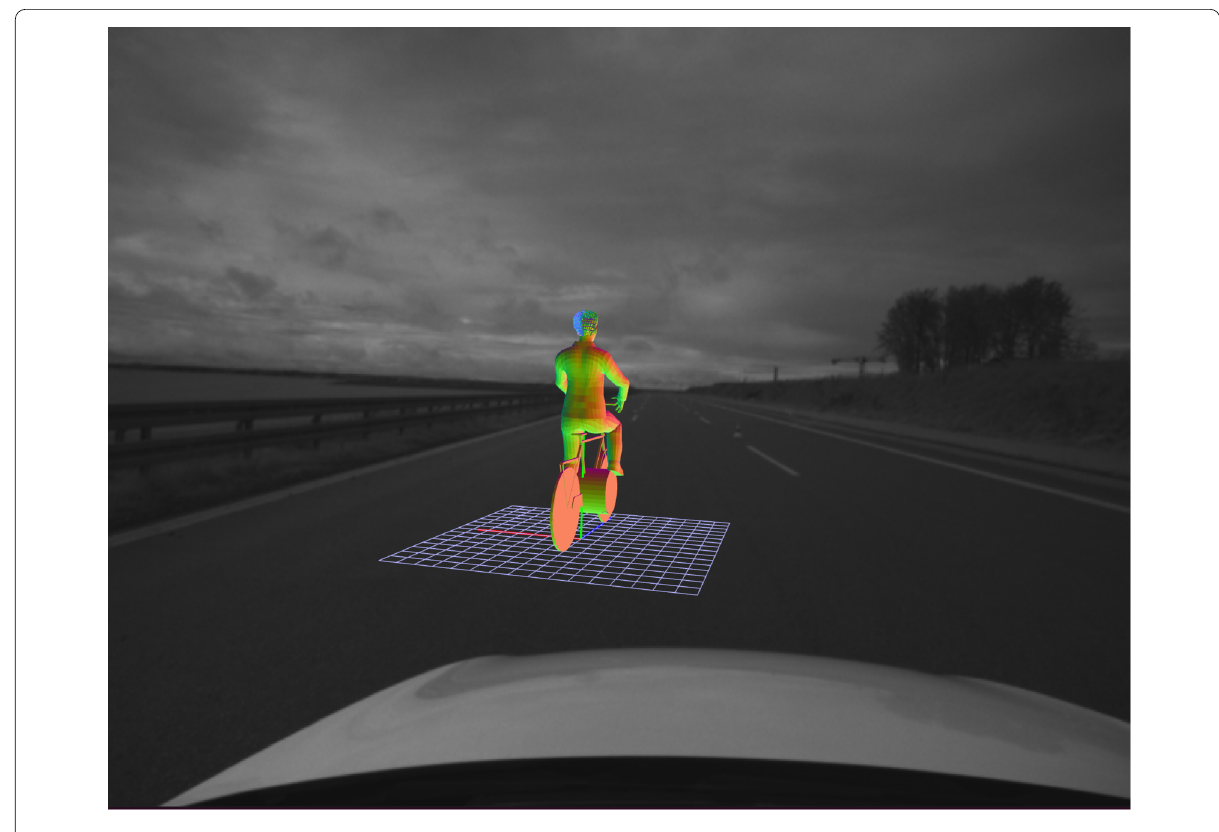
Figure 8 Augmented cyclist in